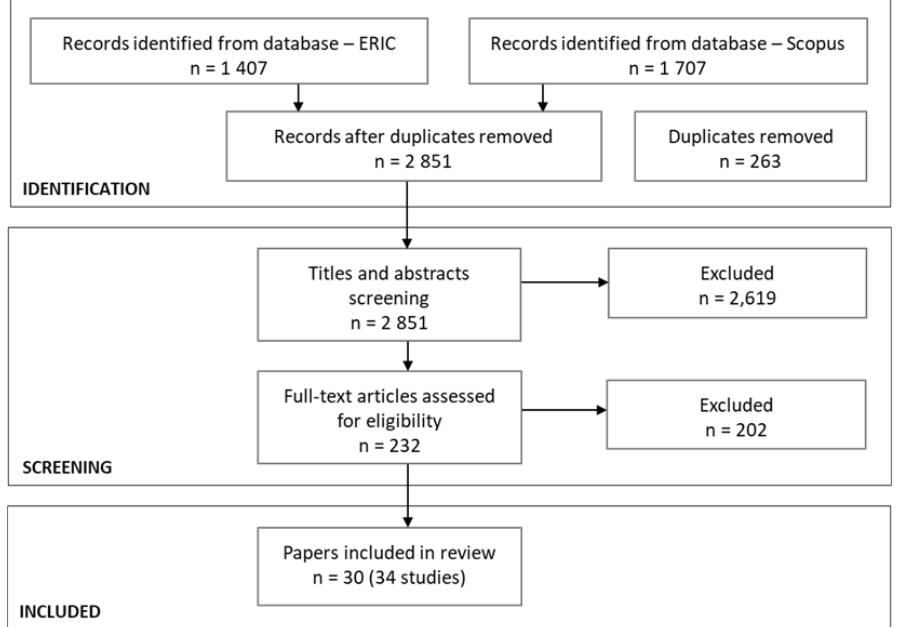
Figure 1. PRISMA flow diagram for the conducted systematic review.